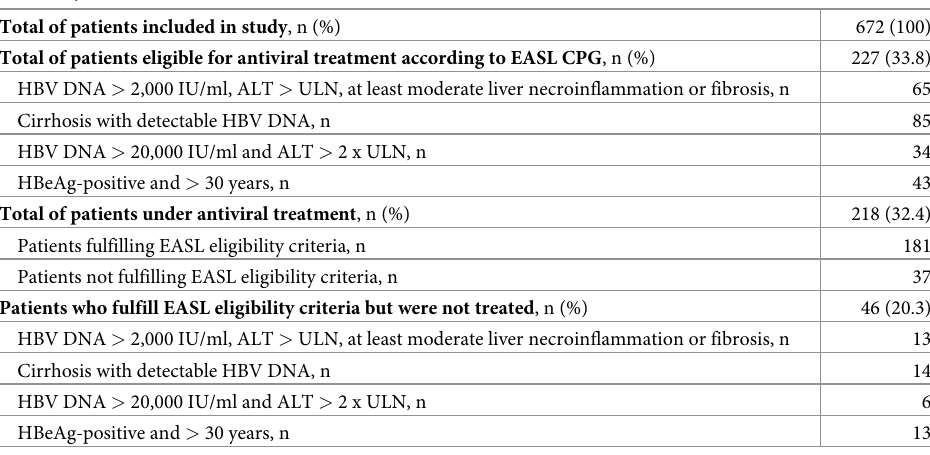
Table 3. Comparison between the number of patients eligible for antiviral treatment according to the latest Euro- pean Association for the Study of the Liver (EASL) Clinical Practice Guidelines (CPG) [1] and patients who were effectively